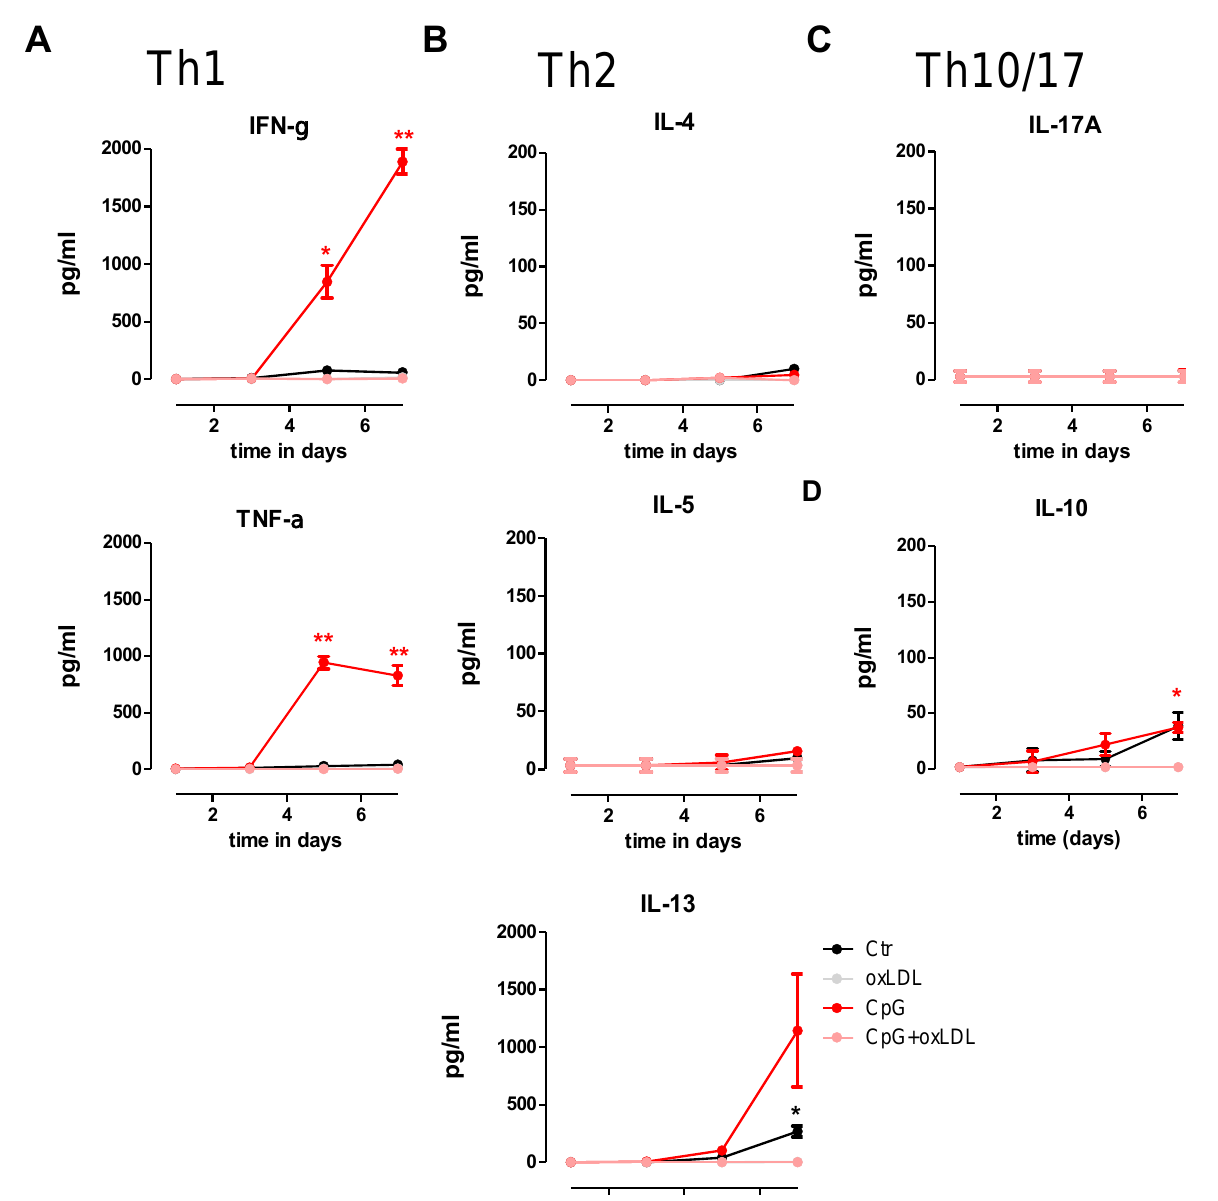
Figure 4. OxLDL skews T cell polarization of CpG-activated pDCs. Human autologous naïve CD4 + T cells were stimulated with immature CpG-A (2.5 µM) challenged pDCs, that had or had not been exposed to 25 µg/mL oxLDL, or with immature pDCs that had only been exposed to 25 µg/mL oxLDL. T cell polarization capacity (Th1, Th2, Th17 or Treg) was analyzed on day 1, 3, 5 and 7 of co-culture by measuring T cell cytokines in the cell supernatant (CBA kit). ( A ) Measurement of Th1 cytokines IFN- γ and TNF- α ; ( B ) measurement of Th2 cytokines IL-4, IL-5 and IL-13; ( C ) measurement of Th17 cytokine IL-17A; ( D ) measurement of Treg cytokine IL-10. Data are shown as means of two independent experiments using different donor pDCs and T cells. * p < 0.05; ** p < 0.01 (color-coded according to treatment).